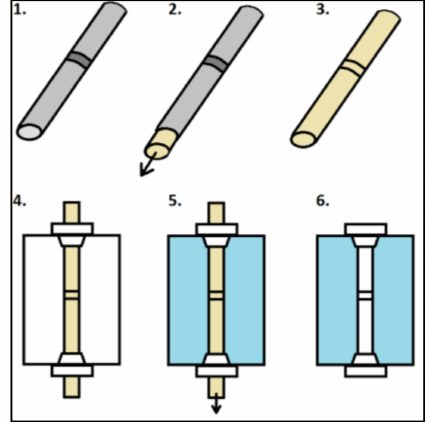
Figure 1. Molding process of a welded tube in schematic form: ( 1 ) welded tube; ( 2 ) molding and removing of the silicone core; ( 3 ) detailed silicone core; ( 4 ) fixing of the core in an aluminum square profile; ( 5 ) filling up the aluminum profile with a transparent silicone and removing of the core after curing; ( 6 ) final replicate for performing optical flow